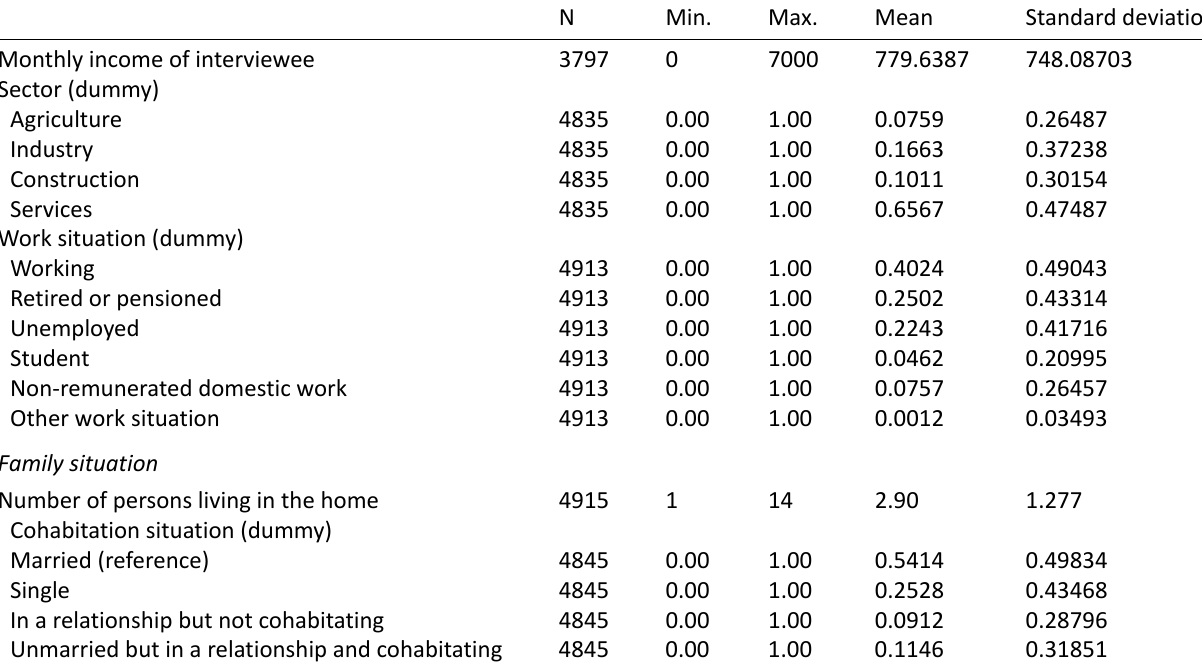
Table 2. (Cont.) Descriptive statistics of the variables in the regression